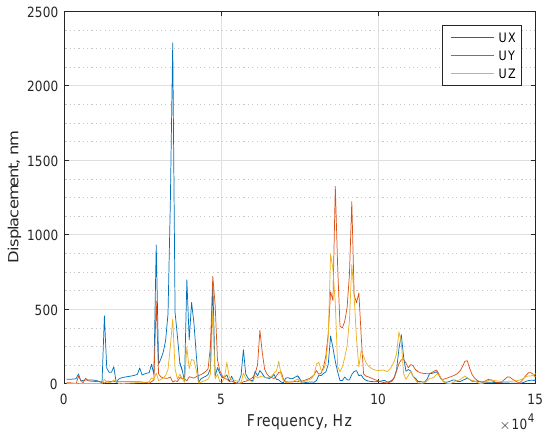
Figure 5. Harmonic analysis: The amplitudes of the contact point in the middle of electrode 4.